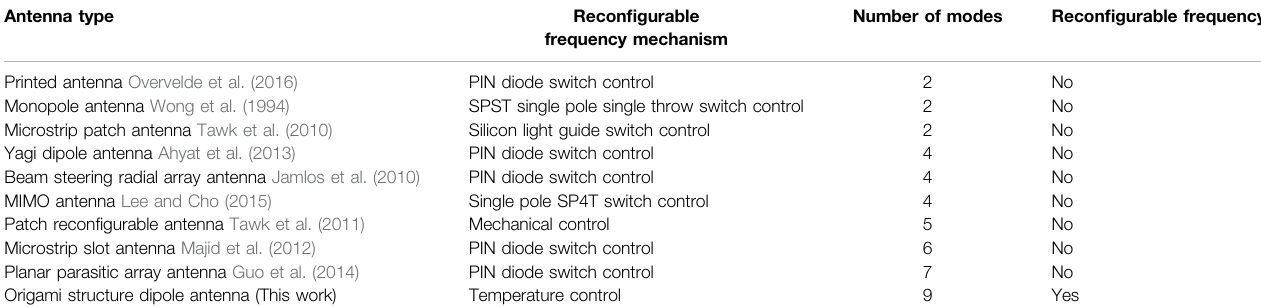
TABLE 1 | Comparison of the frequency recon fi gurable antenna works Antenna type